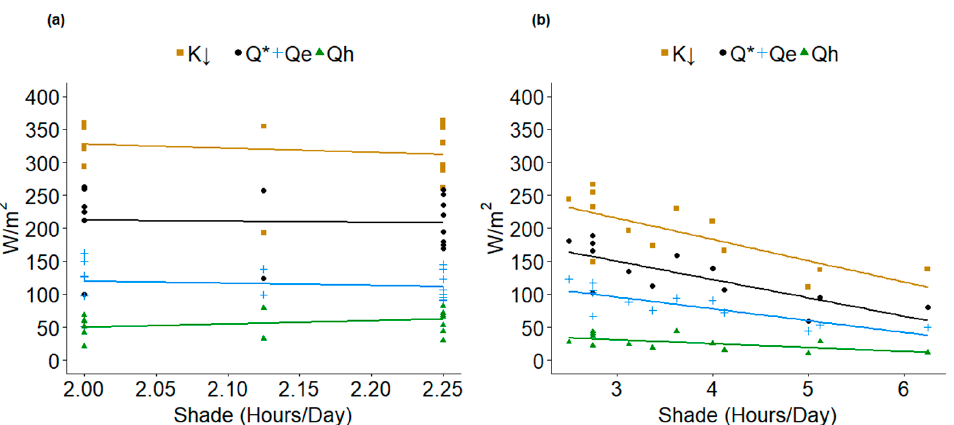
Figure 8. Relationship between hours of shade and solar radiation (K ↓ ) y = − 32.3x + 312.5, net radiation (Q*) y = − 27.8x + 233.6, latent heat flux (Q e ) y = − 5.9x + 48.4 and sensible heat flux (Q h ) y = − 17.9x + 149.4 on clear sky days during the periods of ( a ) Stable Shade and ( b ) Dynamic Shade at Bonsai wetland, Fortress Mountain, Alberta, 2018. Regression equations represent the relationship during the period of Dynamic Shade.